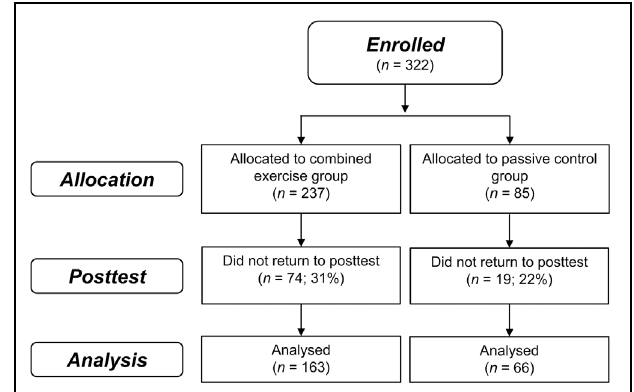
FIGURE 1 | Flow of participant chart. Flow of participants within the intervention and passive control group.